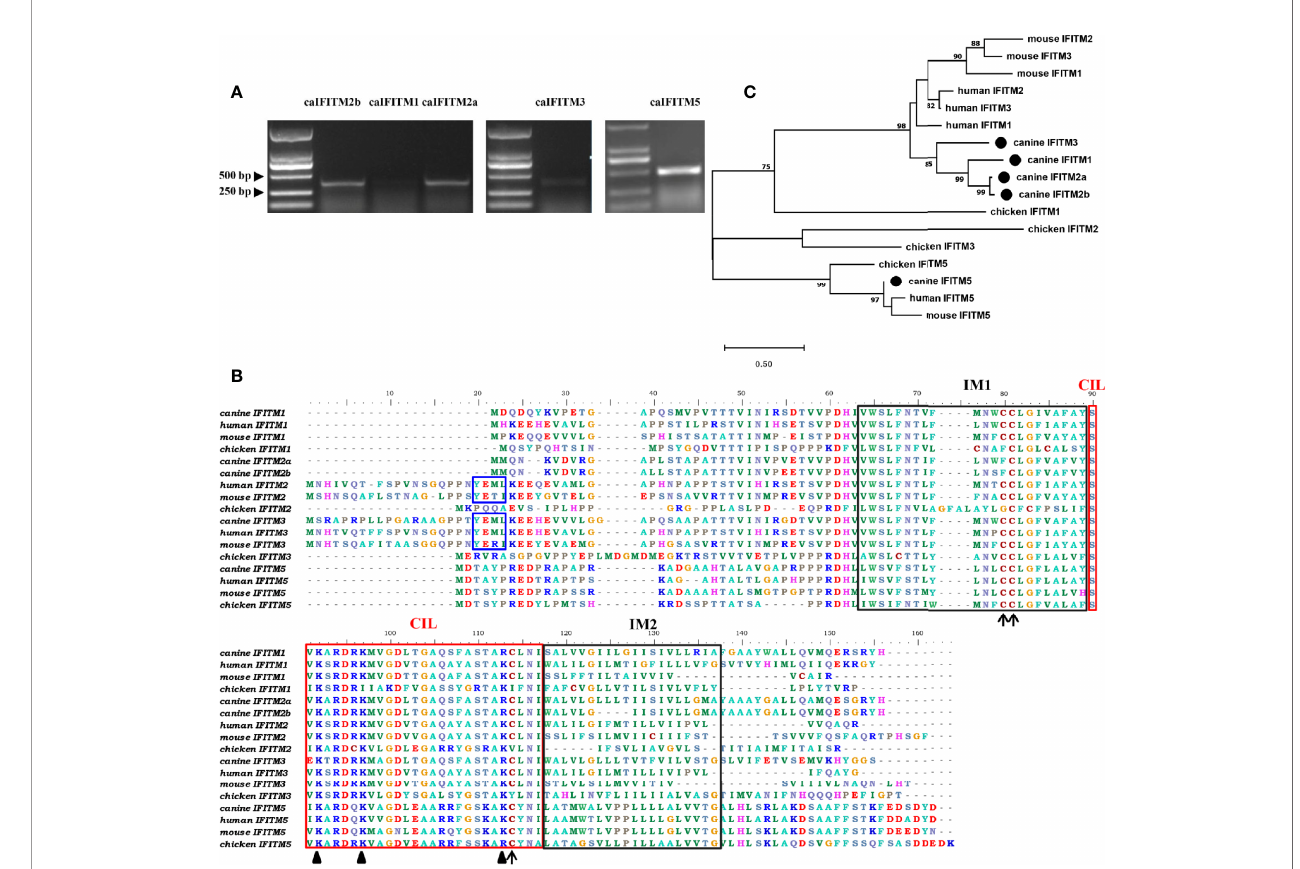
FIGURE 2 | PCR ampli fi cation, sequence alignment, and phylogenetic analysis of caIFITMs. (A) Agarose gel electrophoresis result of caIFITMs. (B) Sequence alignment of caIFITMs with their homologs. The YXX F sorting motif, two TM regions, and CIL region were indicated by a box in blue, black, and red, respectively. The amino acids important for the antiviral activity of IFITMs were revealed by an arrow and a triangle, respectively. (C) Phylogenetic analysis of caIFITMs with their homologs. A maximum-likelihood tree was generated using MEGA 7.0 based on 1,000 bootstrap values. caIFITMs were indicated by a